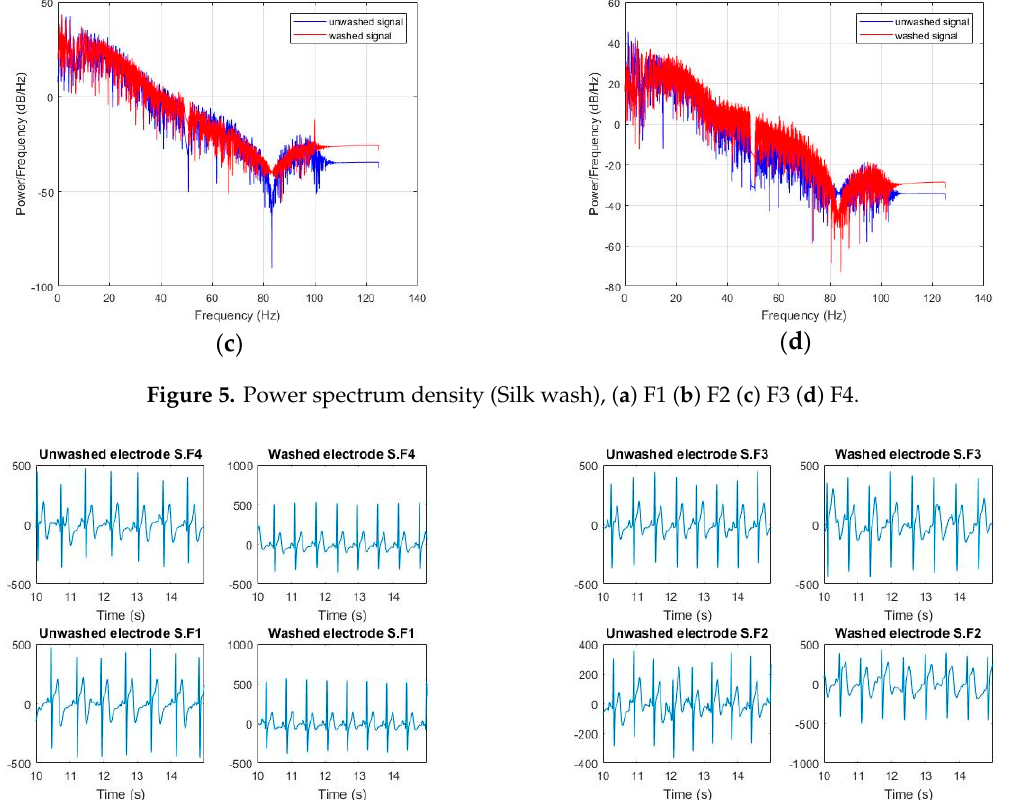
Figure 6. ECGs measured (silk wash). ( a ) F1 and F4 ( b ) F2 and F3.